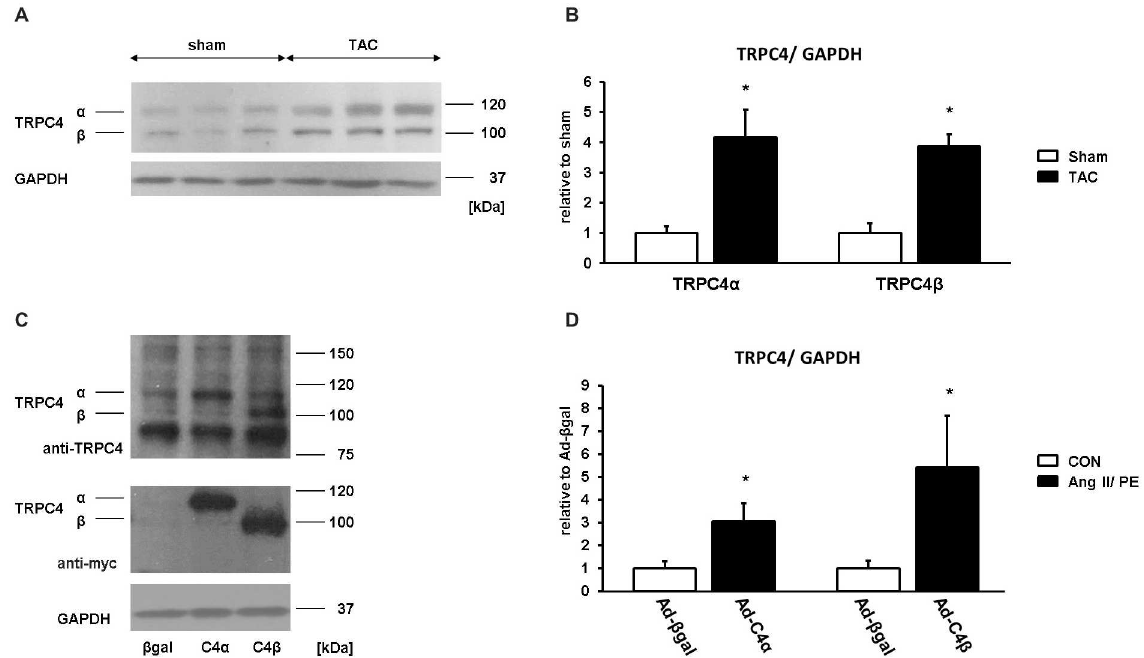
Fig 1. Enhanced expressionof TRPC4 α and TRPC4 β after pressureoverload-induced cardiac hypertrophy. A, Expression levels of TRPC4 α and TRPC4 β were analyzedin mouse heart homogenates from transverse aortic constriction (TAC) or sham treated mice (3 mice/group). B, quantification of TRPC4 α and TRPC4 β expressionlevels relative to sham controls. * P < 0.05vs Sham. C. Detection of TRPC4 α and TRPC4 β in lysates from neonatalrat cardiomyocytes with TRPC4 or myc-tag antibodies. D, Average quantified values of TRPC4 α and TRPC4 β signals expressedrelativeto Ad- β galfor n = 3 experiments. * P < 0.05vs Ad- β gal CON. Glyceraldehyde3-phosphate dehydrogenase (GAPDH) was used as